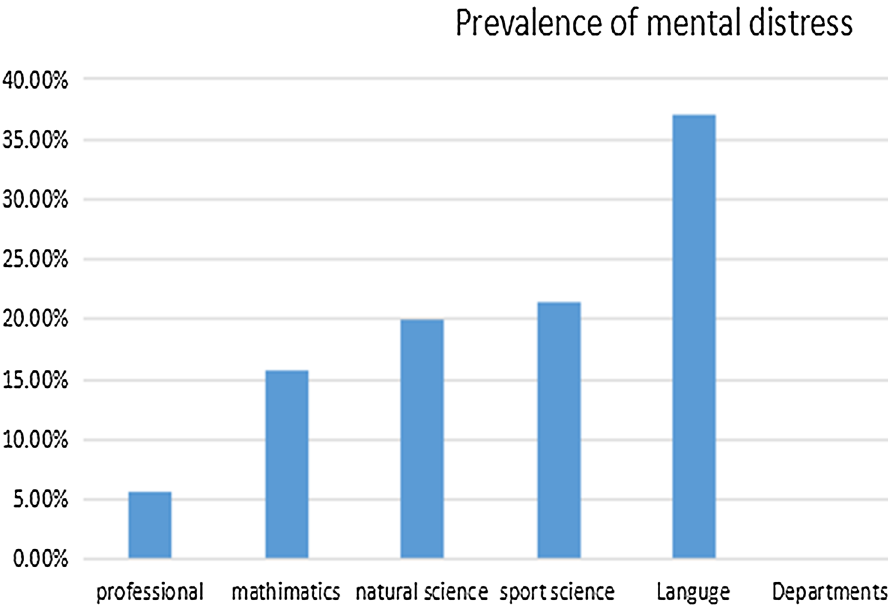
Figure 1. Prevalence of mental distress among college students in Kemisie district across